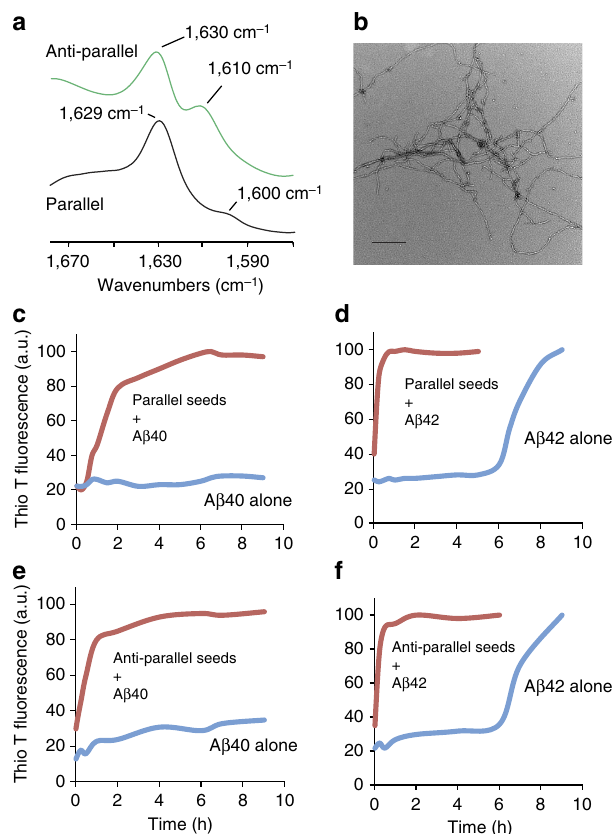
Figure 1 | A b 40-DI CAA mutant amyloid fibril seeds promote the rapid assembly of wild-type A b 40 and A b 42 fibrils. ( a ) FTIR spectra of A b 40-DI having anti-parallel (green) and parallel (black) b -sheet secondary structure. The anti-parallel fibrils were formed at 4-6 (cid:2) C using the protocol of Tycko 22,23 (Supplementary Fig. 2) and are stable to at least 22 (cid:2) C (Supplementary Fig. 3). ( b ) TEM of anti-parallel A b 40-DI obtained at 22 (cid:2) C. Scale bar, 150nm. Freshly prepared solutions of wild-type A b 40 ( c , d ) or wild-type A b 42 ( e , f ) were incubated in the absence (blue) or presence (red) of parallel ( c , e ) or anti-parallel ( d , f ) A b 40-DI fibrillar seeds. The rate and extent of fibril formation was assessed by thioflavin T fluorescence measurements at 37 (cid:2) C. TEM, transmission electron microscopy.